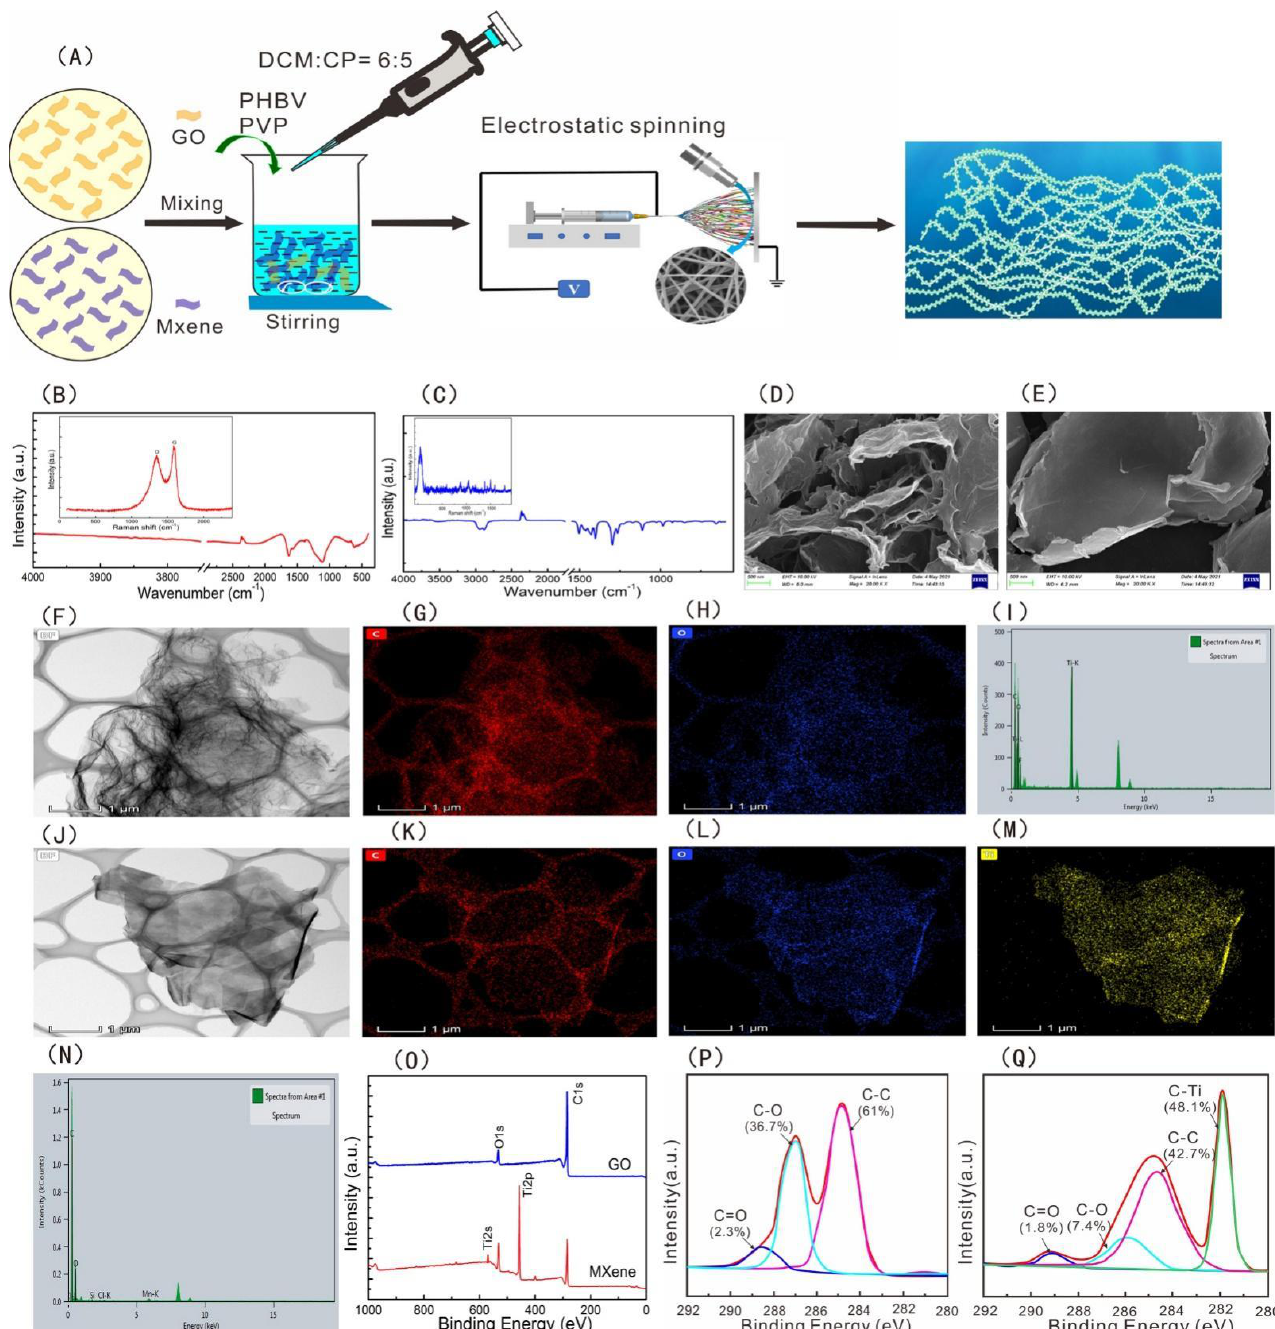
Figure 1. Schematic diagram of preparation of the PHBV—GO/MXene composite membranes ( A ), FT-IR and Raman spectra of GO ( B ), and MXene ( C ); SEM images of GO ( D ) and MXene ( E ). TEM analysis of GO ( F ) and MXene ( J ). Distribution of elements: C for GO ( G ), O for GO ( H ), C for MXene ( K ), O for MXene ( L ), and C for MXene ( M ). The element composition of GO ( N ) and MXene ( I ). XPS spectra of GO and MXene ( O ). C1s XPS spectra of GO ( P ) and MXene ( Q ).